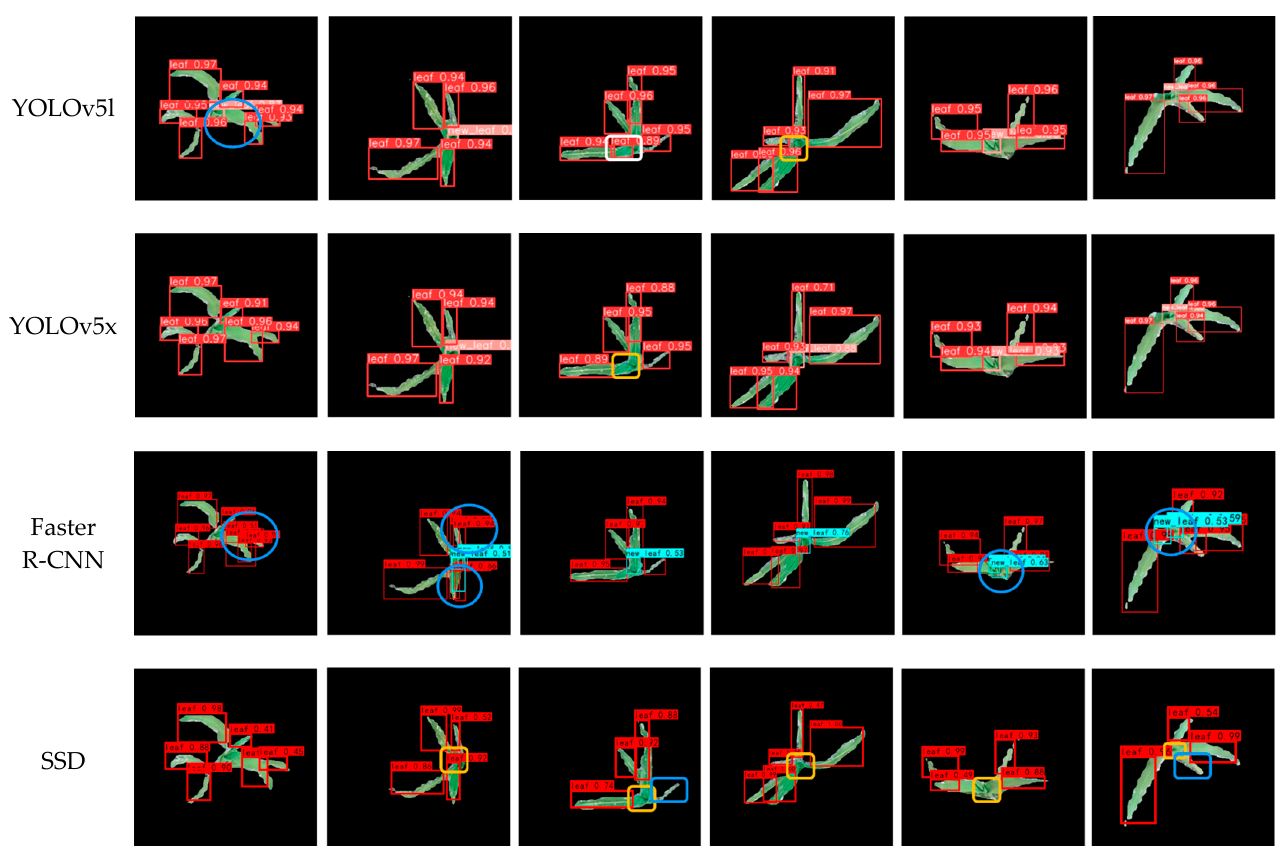
Figure 8. Visualization results of leaf detection for different models on the different test sets. ( a ) The maize seedlings without newly appeared leaves; ( b – f ) the maize seedlings with newly appeared leaves. The first column is a partial view of the original image. The second column is the segmented individual maize seedling. The remaining columns are the detection results with seven different models. The blue and yellow rectangles are missed fully unfolded leaf and newly appeared leaf inspection. The blue circle is the multi-inspection of leaves. The white rectangular box is the false detection of newly appeared leaf.